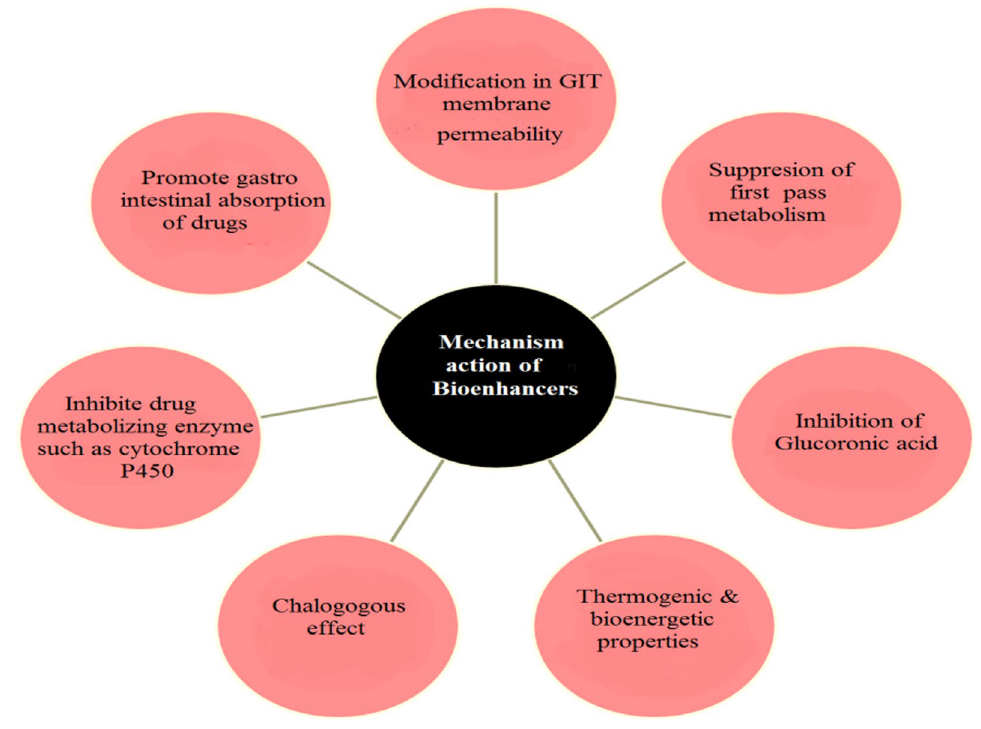
Fig. 3 Mechanism of different natural bioenhancers [28]